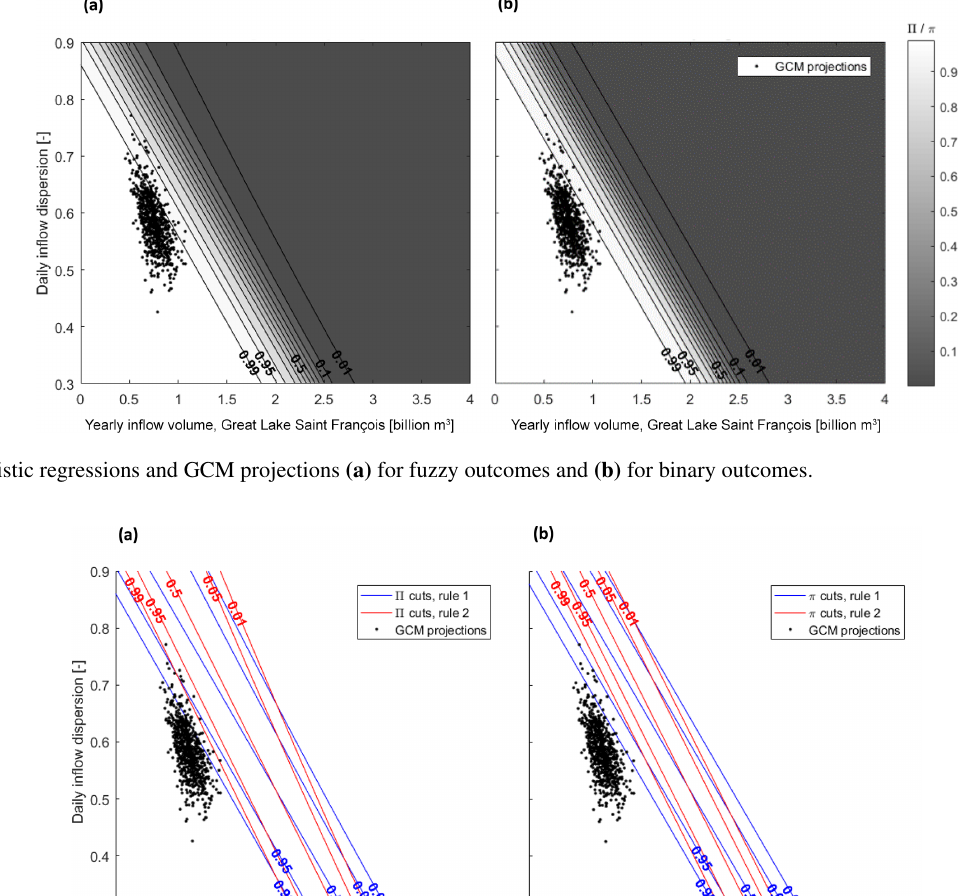
to the same state of the world would produce an unacceptable